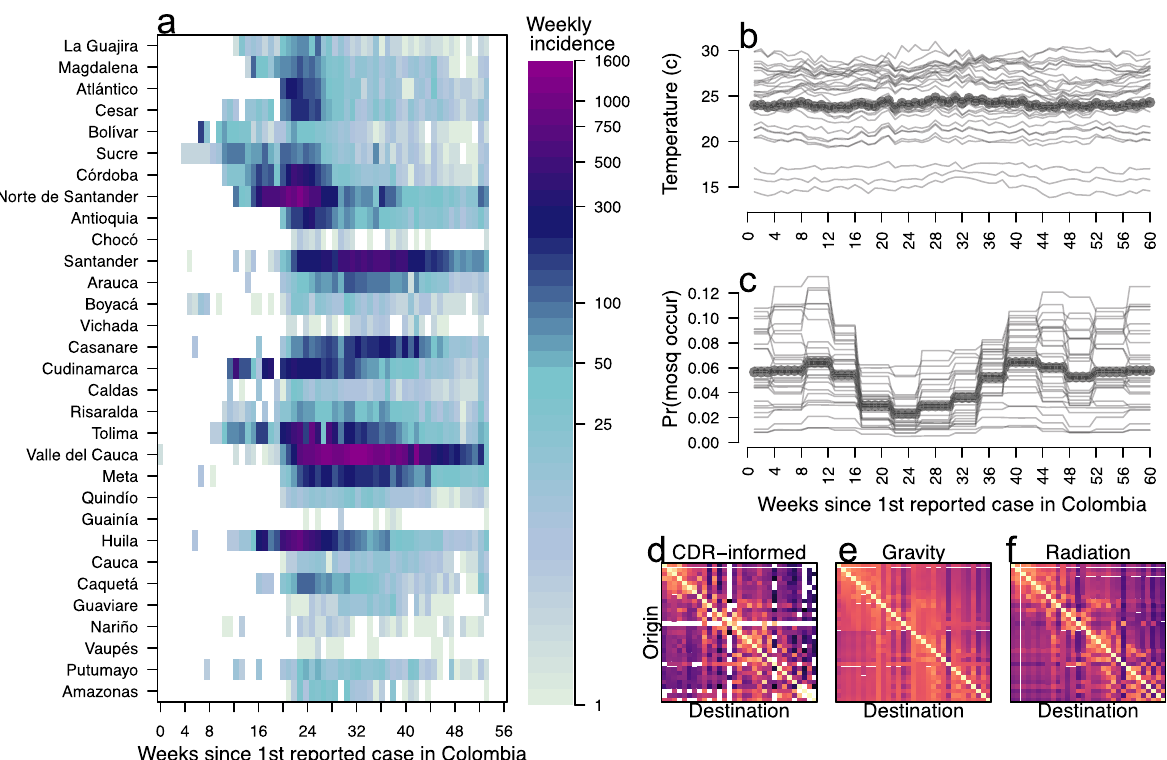
Fig. 1 Temporal and spatial variation of Zika incidence, temperature, and mosquito occurrence probability in Colombia. a Weekly Zika incidence from August 9, 2015 to October 1, 2016 with all 31 mainland departments approximately ordered from south to north. b Points indicate average temperature data and lines indicate temperature by the department. c Points indicate average mosquito occurrence probability and lines indicate mosquito occurrence probability by the department. d – f Mobility matrices under three different assumptions of mobility (CDR-informed denotes a mobility matrix derived from call data records), with departments ordered south to north on the y -axis and north – south on the x -axis. Tan indicates high rates of mobility, dark purple indicates low rates of mobility, white indicates no movements.